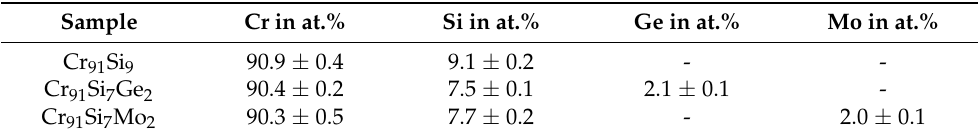
Table 1. Measured compositions of the tested binary and ternary alloys after melting and annealing at 1200 ◦ C for 100 h. Sample Cr in at.% Si in at.% Ge in at.%